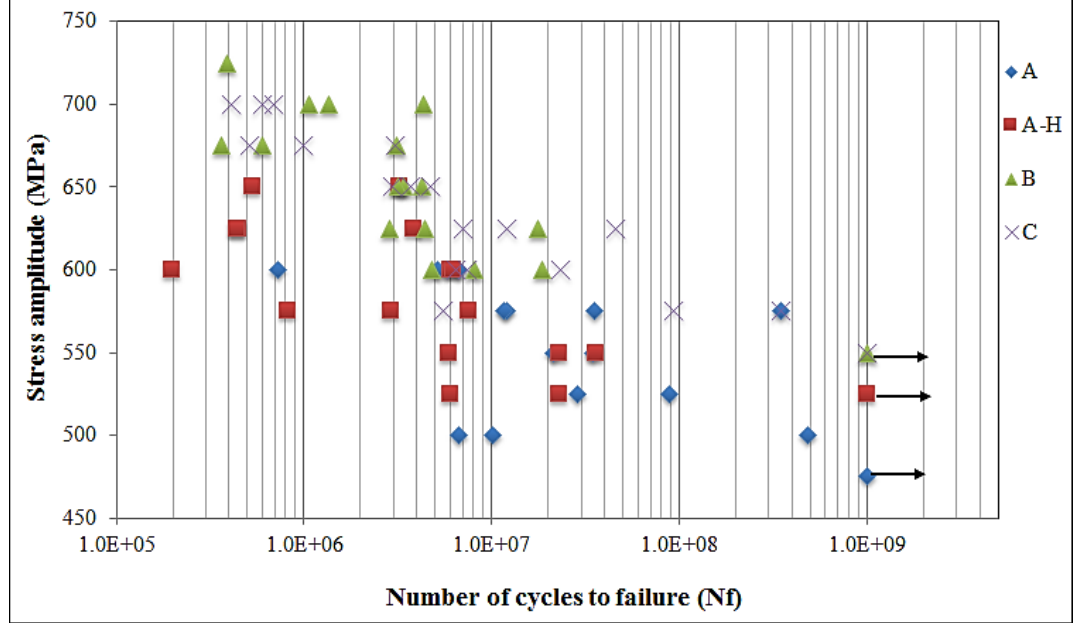
Figure 21. Fatigue results of different Ti6Al4V samples (arrows denote the run-out